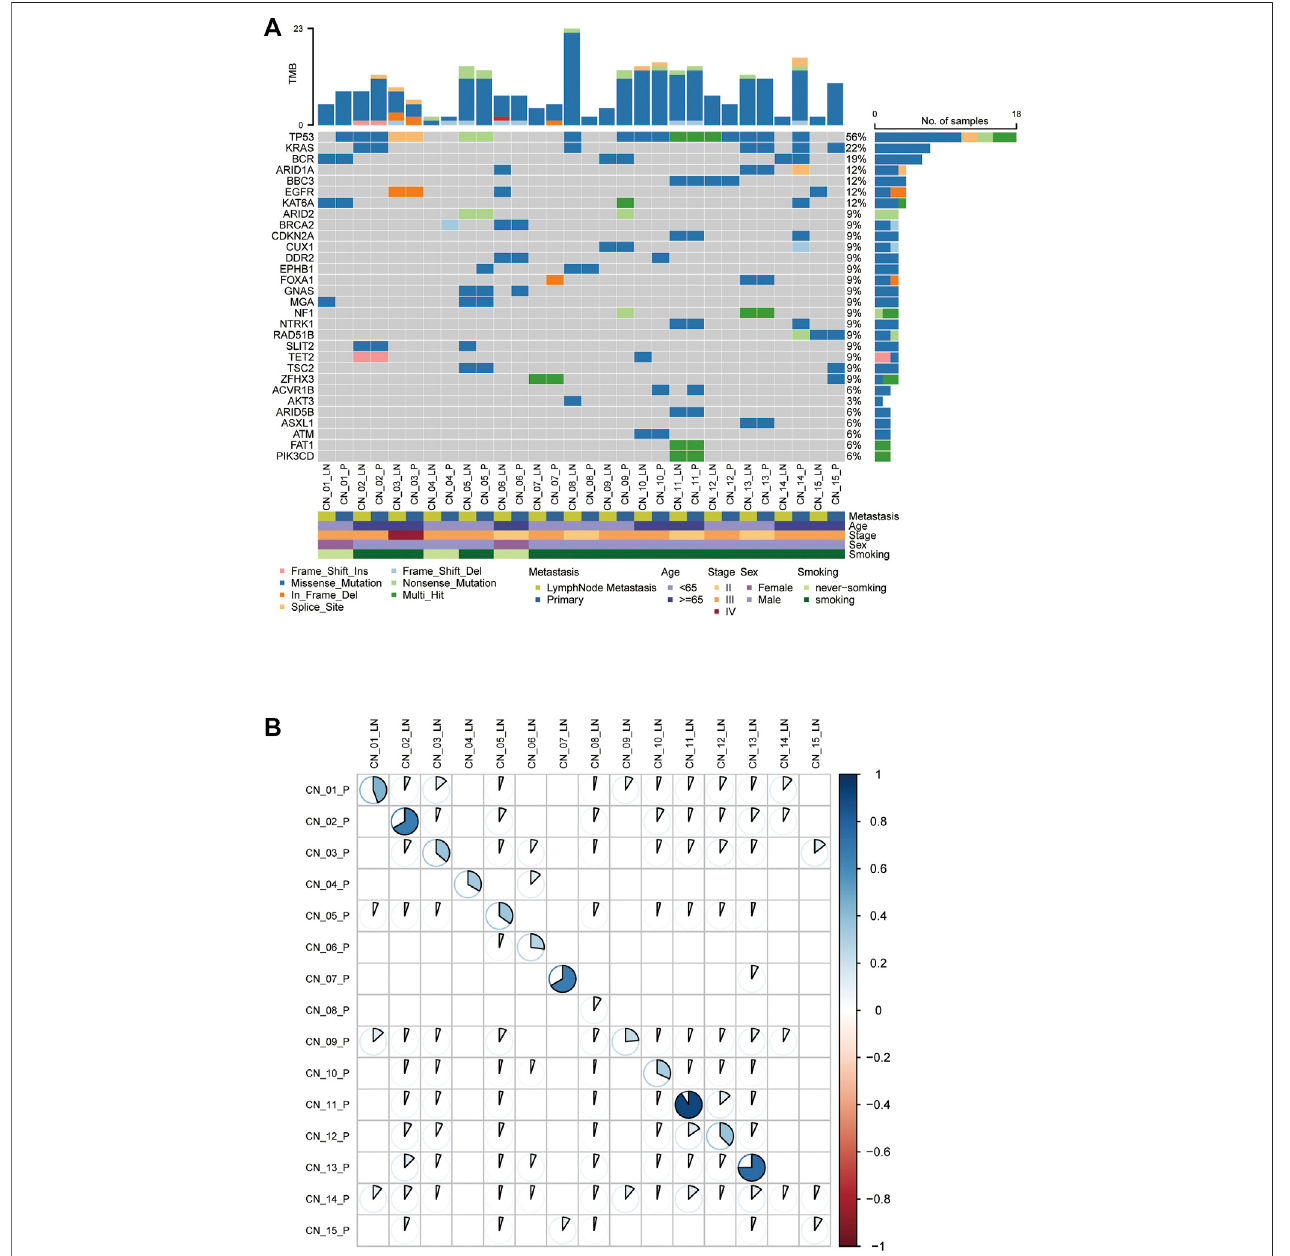
FIGURE1| ThegeneticlandscapeofmetastaticNSCLCpatients. (A) Comparison ofthemutationallandscapebetweenprimarylesions andtheirpaired lymphatic metastases. The top panel represents the number of somatic mutations in each sample. The middle panel represents the matrix of mutations in a selection of frequently mutated genes. Columns represent samples. The patients ’ characteristics are presented in the following. (B) The Pearson correlation analysis of mutations in paired P-LN. P: primary lesions; LN: lymph nodes metastases.